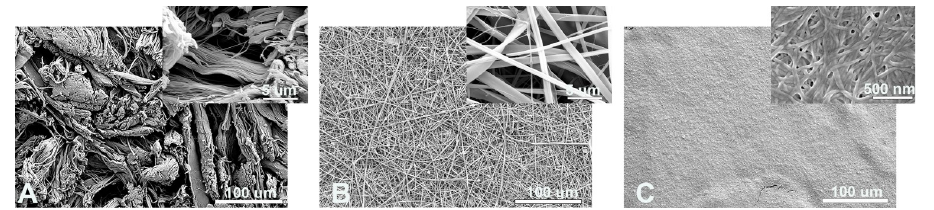
Fig 1. Structure of matrices for engineered lamina propria. Scanning electron micrographs of A) decellularized dermis (DD), B) electrospun collagen (ES), and C) collagen gels. Decellularized dermis was comprised of collagen fiber bundles woven into a crosshatched pattern (A), whereas electrospun collagen was nonwoven with larger individual collagen fibers. Collagen gels were dense in structure, containing smaller collagen fibers. Note the scale bar on the inset is 500 nm versus 5 μ m in the insets for DD and ES